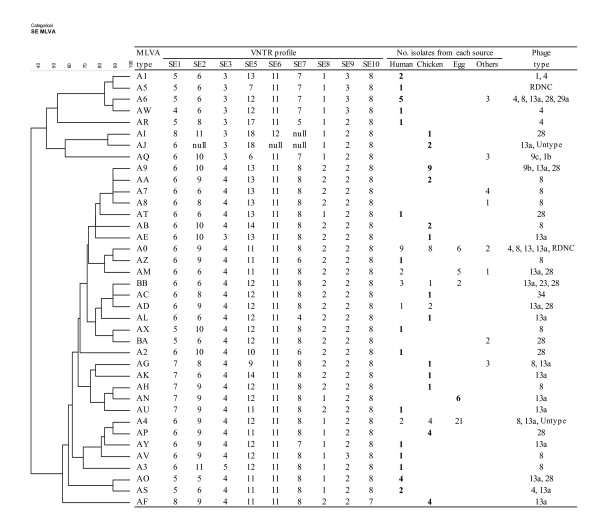
Distribution of MLVA type with sources of isolates and VNTR profiles. The categorical coefficients and UPGMA (unweighted pair group method with arithmetic averages) were used to generate a dendrogram. Null: No amplification of the allele. Bold type represents specific sources of S. Enteritidis (human, chicken, or egg).